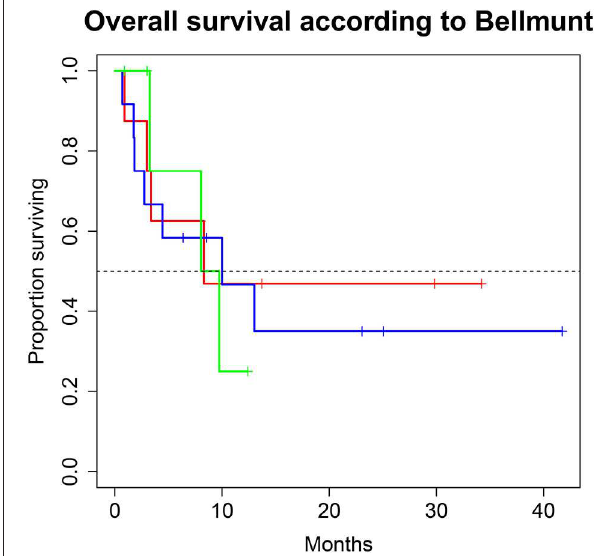
FIGURE 3 | Overall survival (OS) for 28 patients under second line therapy with checkpoint inhibitor monotherapy for metastatic urothelial carcinoma according to Bellmunt criteria [Risk score 0 (green) vs. 1 (blue), vs. ≥ 2 (red)]. OS did not differ between groups (8.3, 10.0 and 8.9 months; p = 0.9).